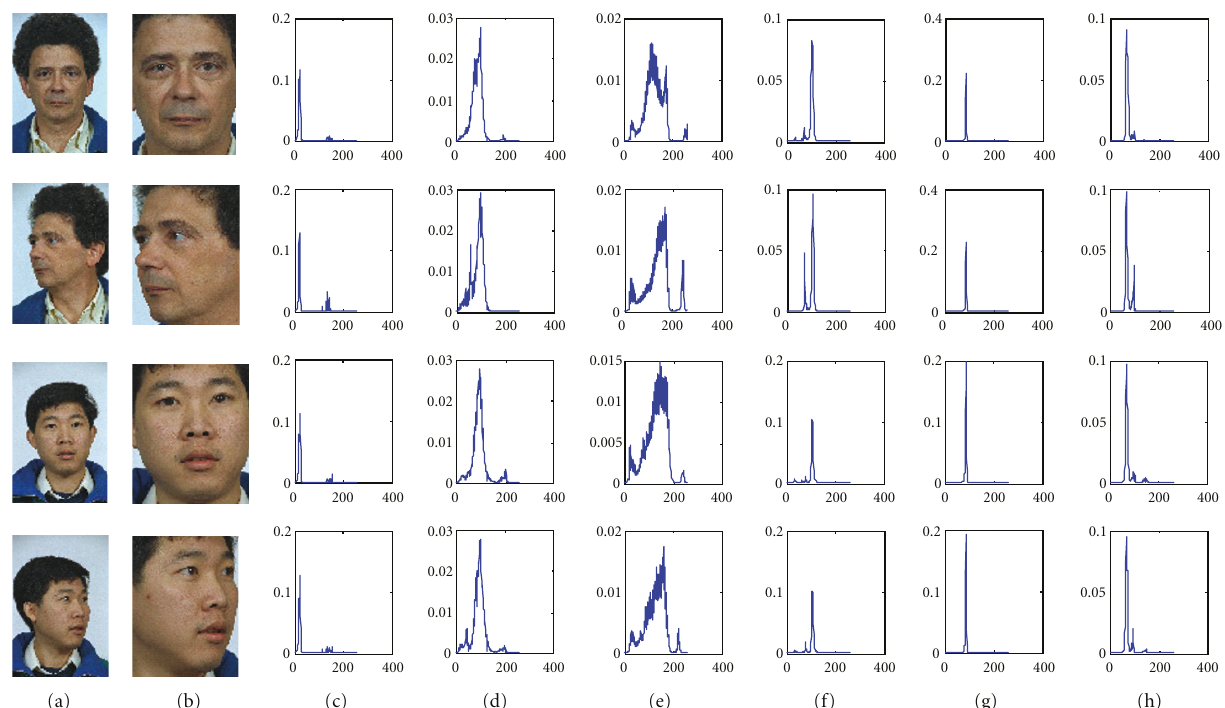
Figure 3: Two subjects from FERET database with 2 di ff erent poses (a), their segmented faces (b) and their PDFs in H (c), S (d), I (e), Y (f), Cb (g), and Cr (h) colour channels respectively.